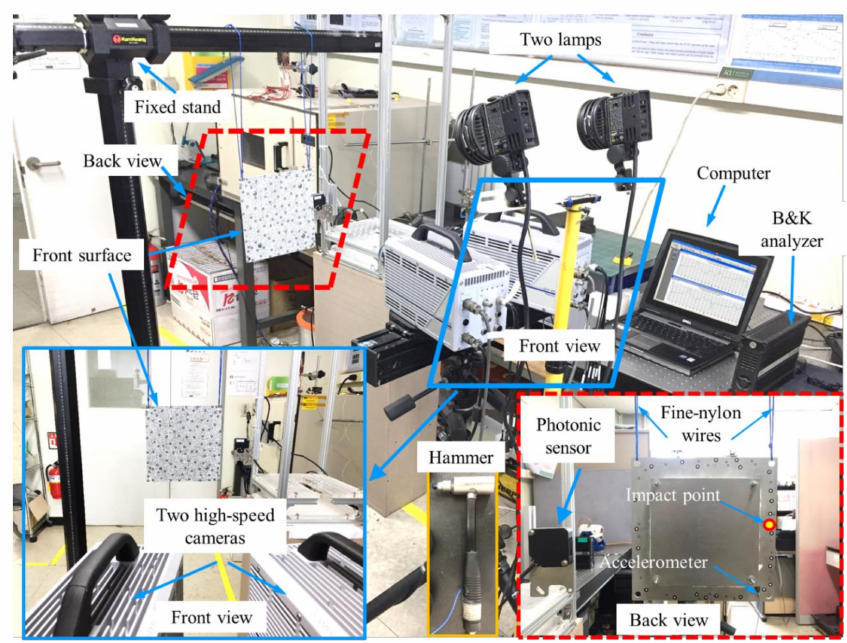
Figure 4. Experimental setup for a dynamic test using high-speed three-dimensional point tracking (3DPT) and an accelerometer.